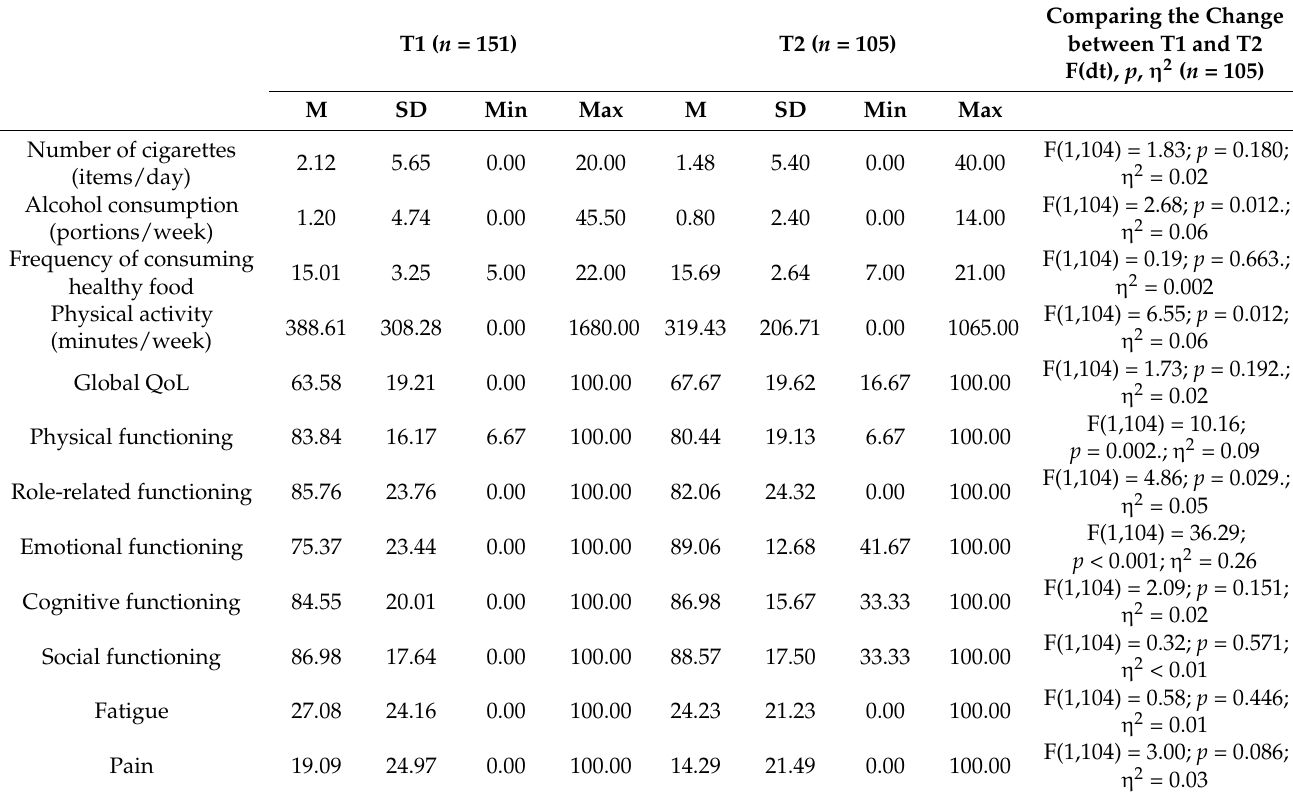
Table 2. Health behaviors and QoL during T1 and